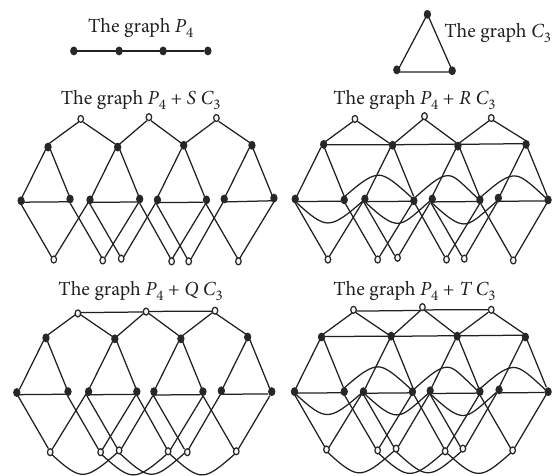
along with its derived 6